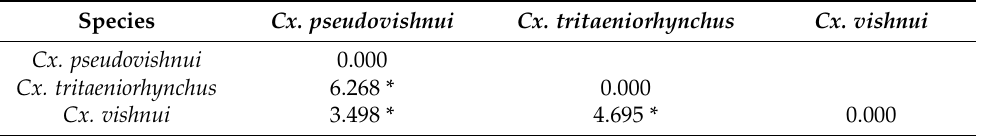
Figure 6. Factor map generated by discriminant analysis of shape variables for Cx. pseudovishnui , Cx. tritaeniorhynchus , and Cx. vishnui. The wing shape variations of each Culex species are repre ‐ The superscript asterisks after Mahalanobis distance values indicate significant differences between Culex species sented by each polygon, and each dot within the polygons represents an individual Culex specimen. at p < 0.05.